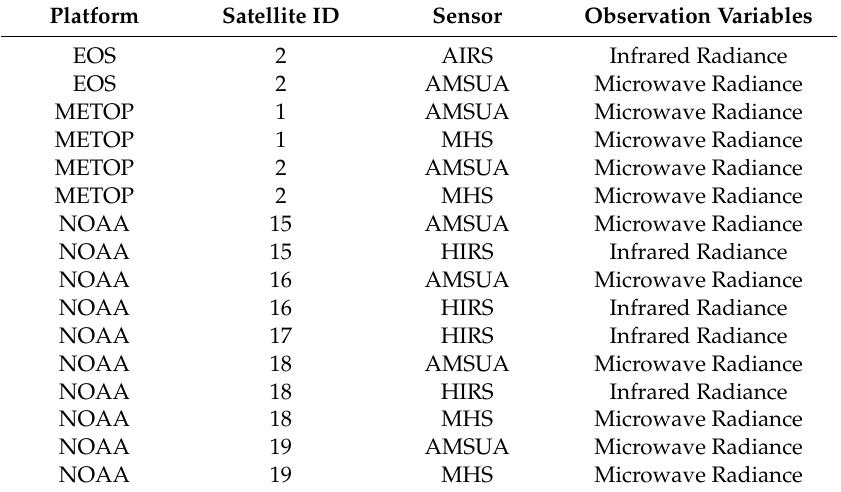
Table 6. Satellite data used for data assimilation. Contains several sensors (AMSUA, HIRS, and MHS, AIRS) on EOS, METOP, and NOAA platforms.